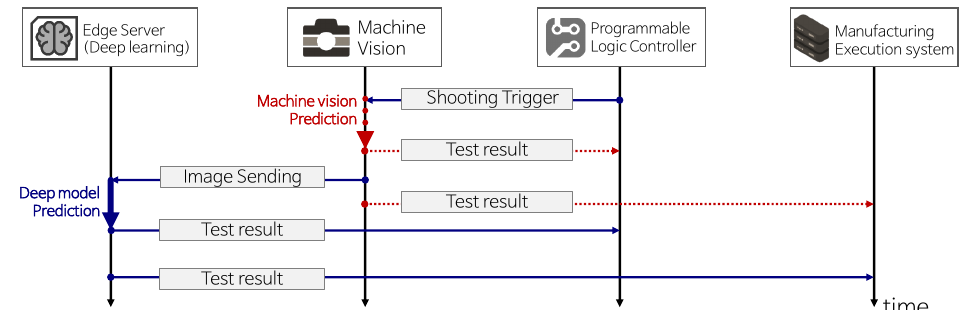
Figure 6. System flowchart to improve the existing system based on deep learning. In order to achieve partial improvements (goals 1 and 2), whole processes (blue arrows and red-dotted arrows) in the flowchart are required. To achieve complete replacement of the old system by deep learning (goal 3), only few processes (blue arrows) are